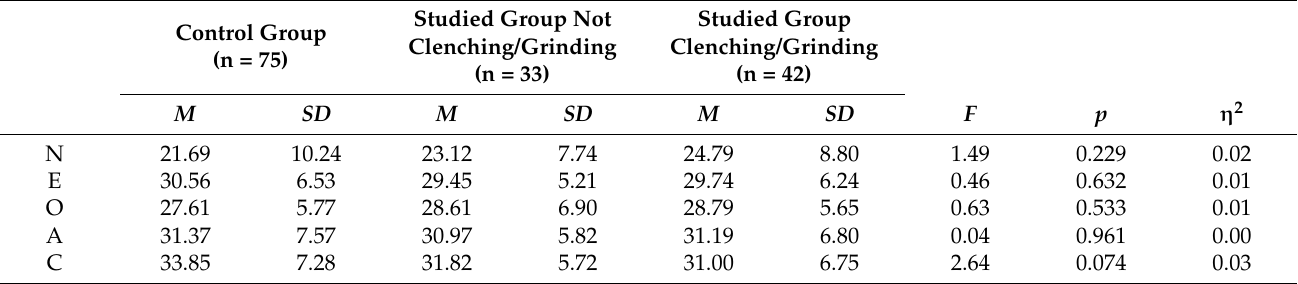
Table 5. One-way analysis of variance for tooth clenching/grinding.